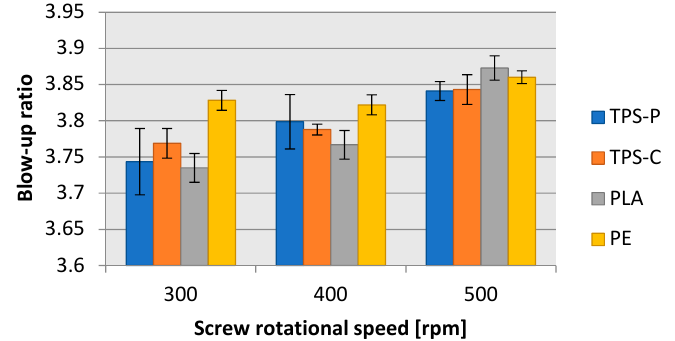
Figure 10. Relationship between the blow-up ratio (degree of transverse stretching) of the obtained film and the rotational speed of the extruder screw.